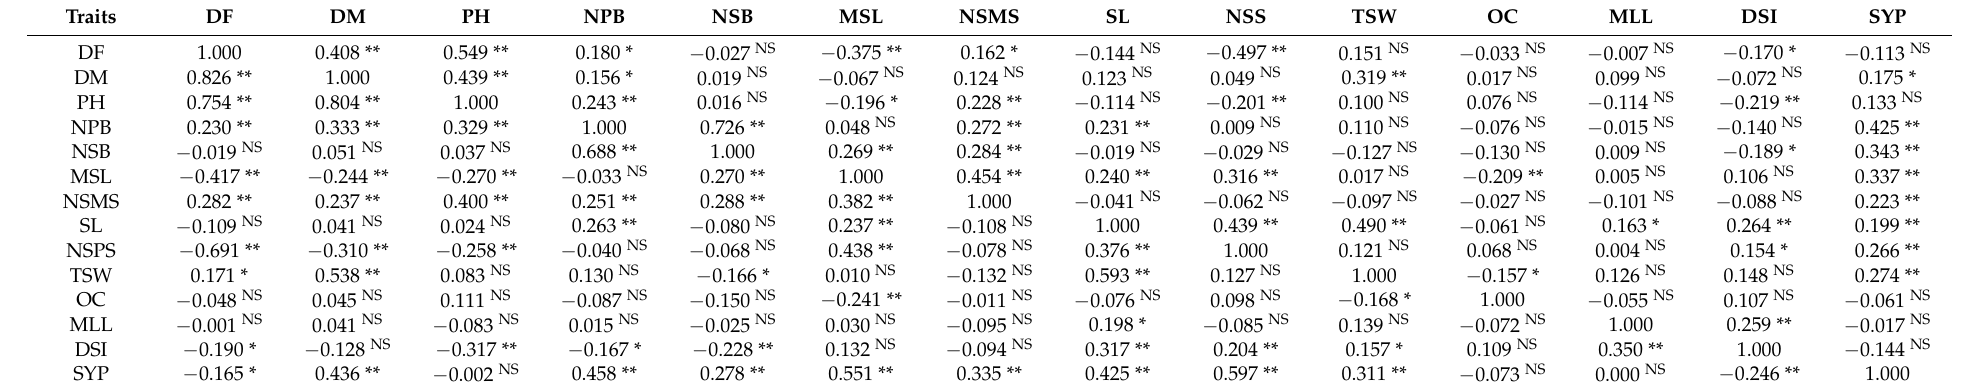
Table 7. Phenotypic (above diagonal) and genotypic (below diagonal) correlation coefficients among Sclerotinia stem rot resistance assessment parameters as well as yield and its component traits in Indian mustard.